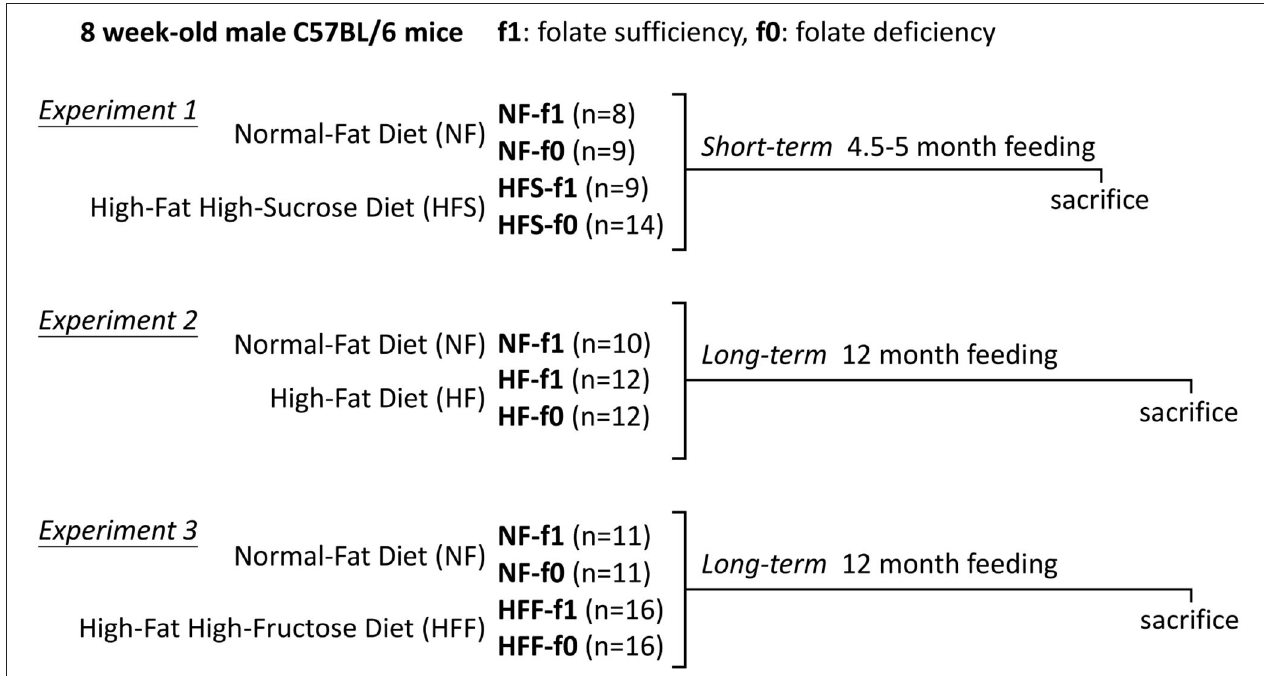
FIGURE 1 | The experimental design for animal